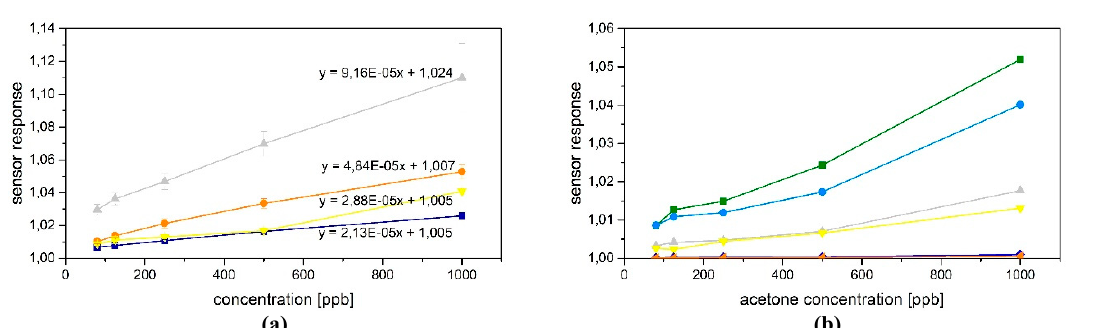
Figure 4. ( a ) Calibration curves (acetone) of Sensirion SGP30 H2 (blue), Sensirion SGP30 EtH (orange), Bosch BME680 (grey), IDT ZMOD 4410 (yellow), ( b ) calibration curves of IDT ZMOD 4410 operated in temperature modulation mode (each line representing a temperature from 50 °C (orange) to 300 °C